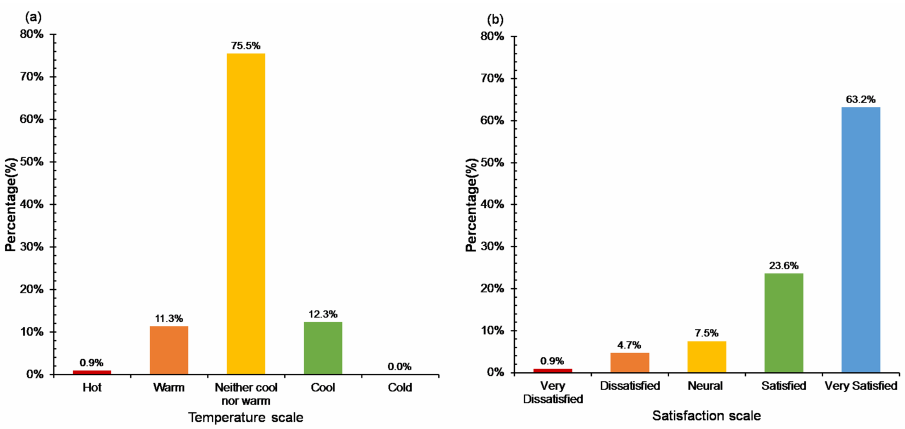
Figure 9. Pupils’ perception ( a ) and satisfaction ( b ) with classroom temperature. 203